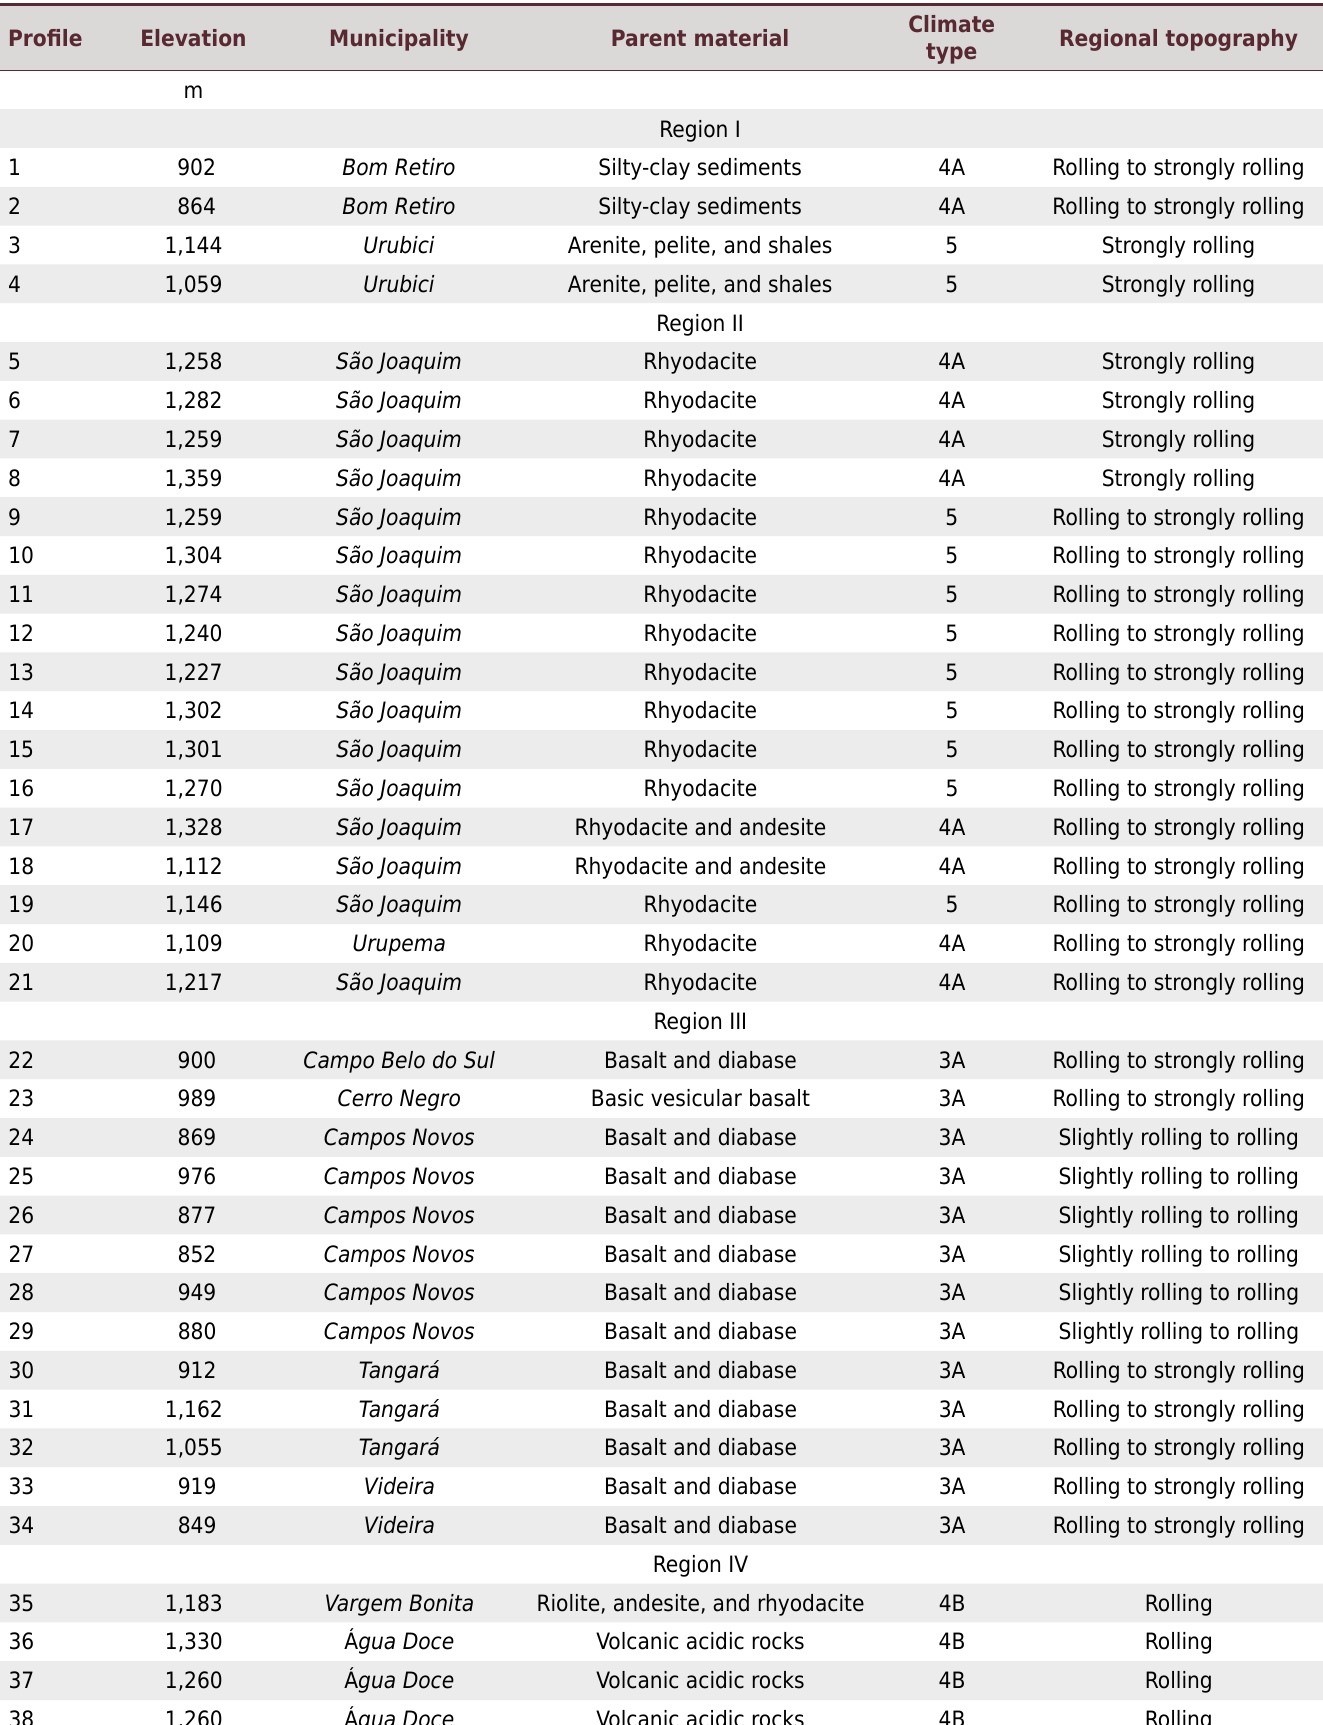
Table 1. Soil profiles according to region, and general characteristics of the sampling points in the high mountain regions in the state of Santa Catarina, Brazil